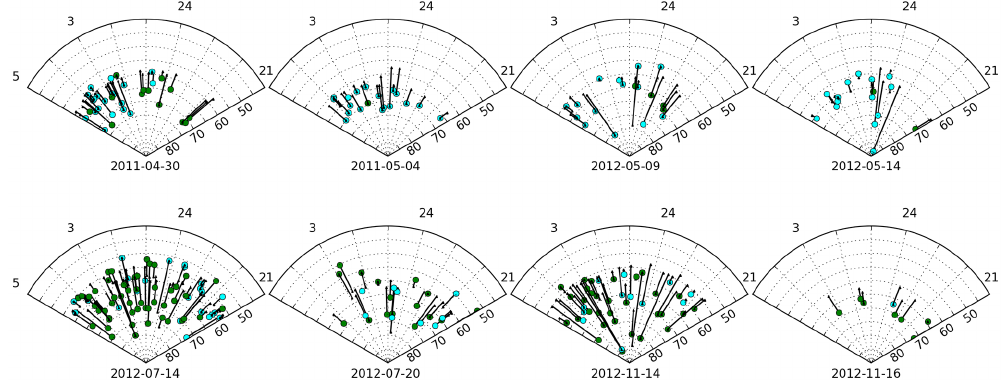
Figure 4. E layer dominant electron density profile locations versus magnetic latitude and MLT for selected days in the four storm periods. MLT range is 21:00–05:00. Green circles are Northern Hemisphere. Cyan circles are Southern Hemisphere. A line connects each circle to the climatological equatorward boundary of the auroral oval, indicated as a black triangle. The boundary is determined based on the IRI2012 model computation (Bilitza et al., 2014; Zhang and Paxton,